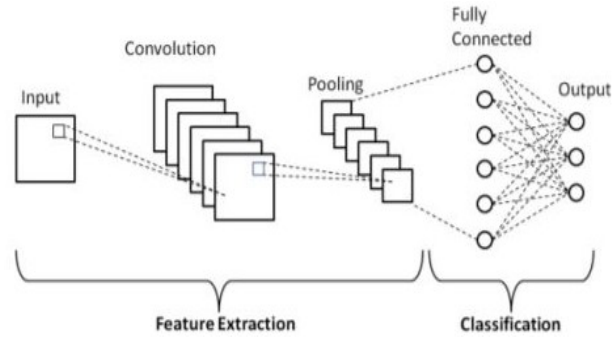
Figure 1. Underlying convolutional neural network (CNN) architecture